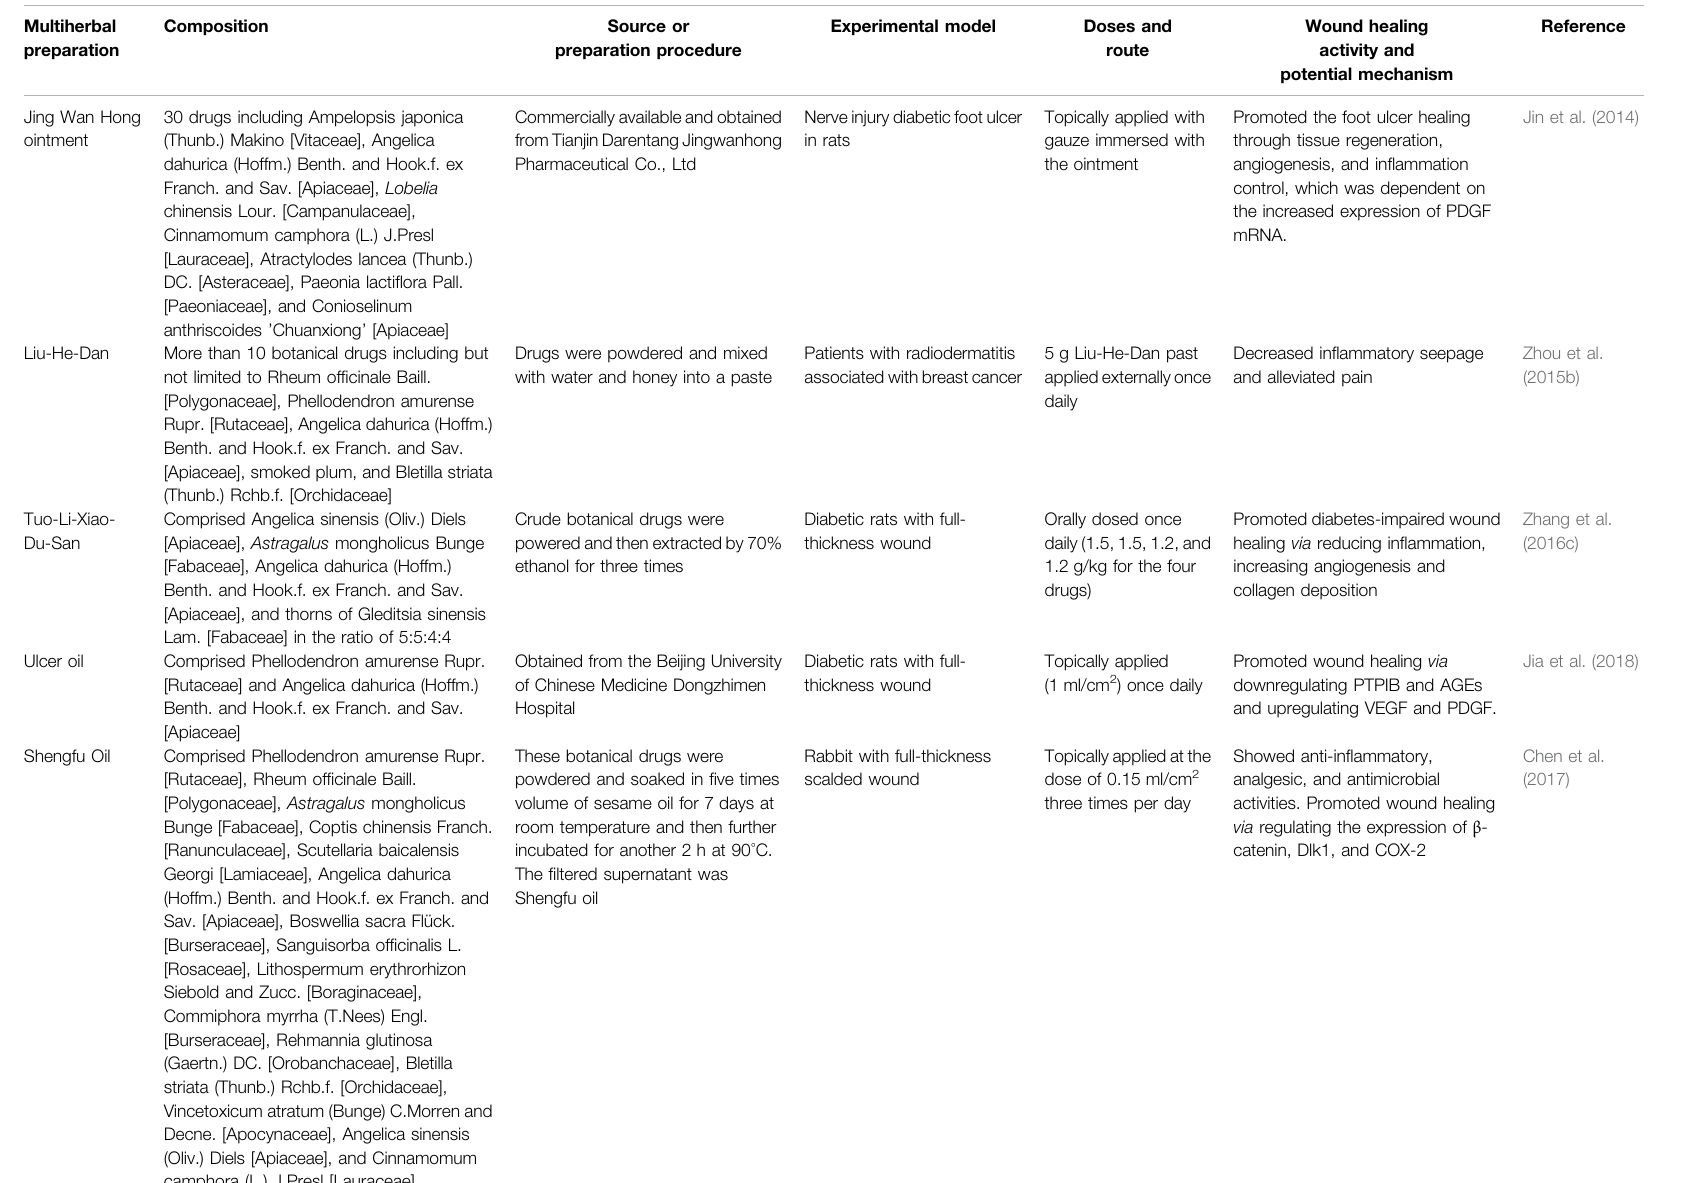
TABLE 2 | Multiherbal preparations and their wound healing